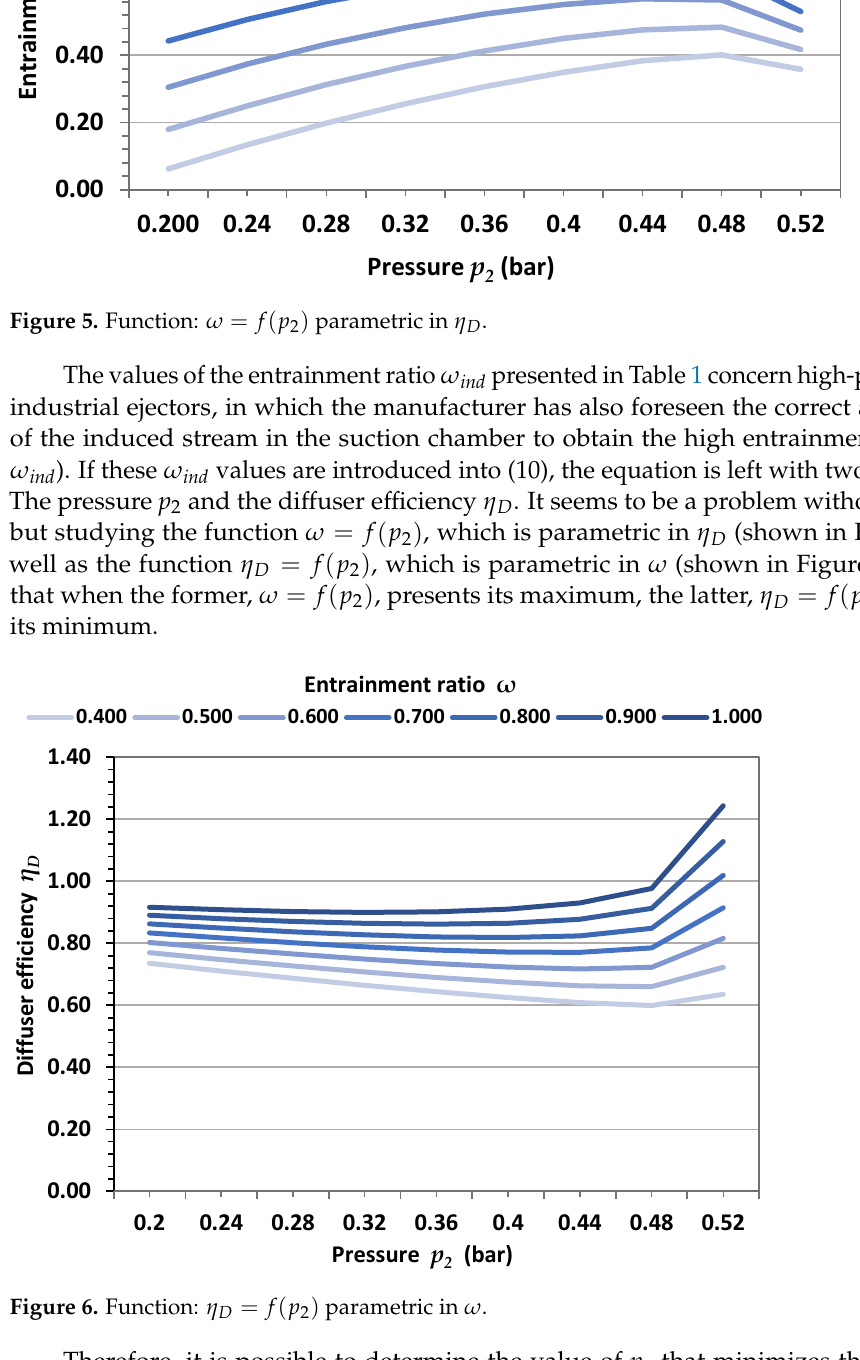
= f ( p ) parametric in ω D 2